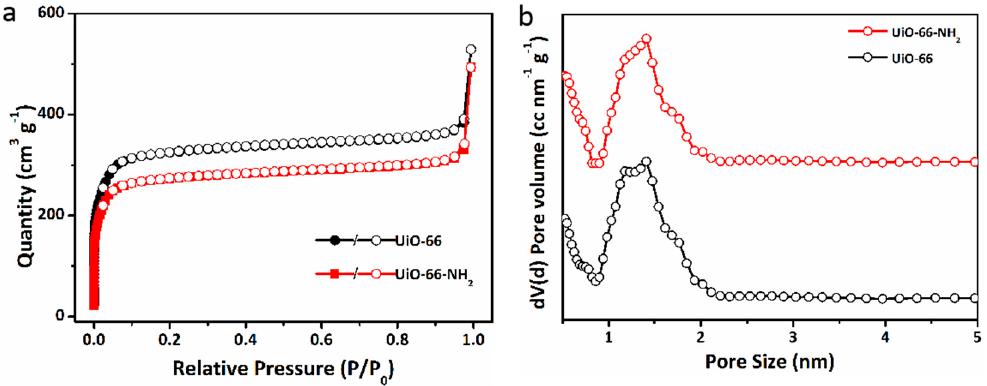
Figure 3. N 2 isotherms at 77 K ( a ) and pore distribution curves ( b ) calculated from absorption curves by the NLDFT mode of UiO ‐ 66 and UiO ‐ 66 ‐ NH 2 .